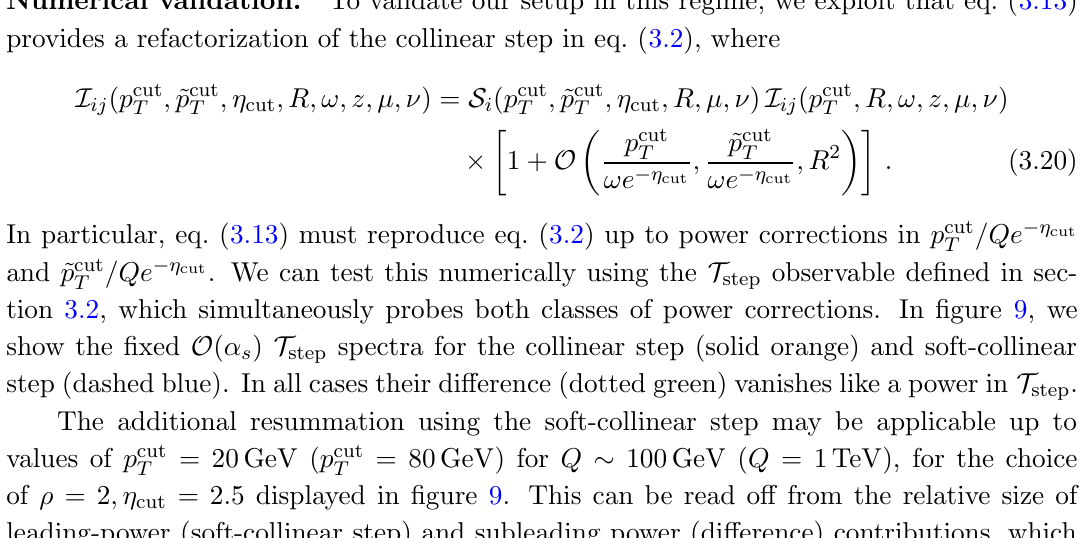
Figure 9 . Comparison of the singular contributions to the (cid:12)xed ( (cid:11) s ) (LO 1 ) spectrum for O T step (cid:17) cut = 2 : 5 and (cid:26) = 2 for gg H (top left), gg X (top right), and Drell-Yan at Q = m Z (bottom ! ! left) and Q = 1 TeV (bottom right). The solid orange lines show the singular spectrum for the collinear-step regime and the blue dashed lines the further factorized result in the soft-collinear- step regime. Their di(cid:11)erence, shown by the dotted green lines vanishes as a power of . The T step vertical lines indicate where the parametric relation =Q = e (cid:0) (cid:17) cut is satis(cid:12)ed. T step Numerical